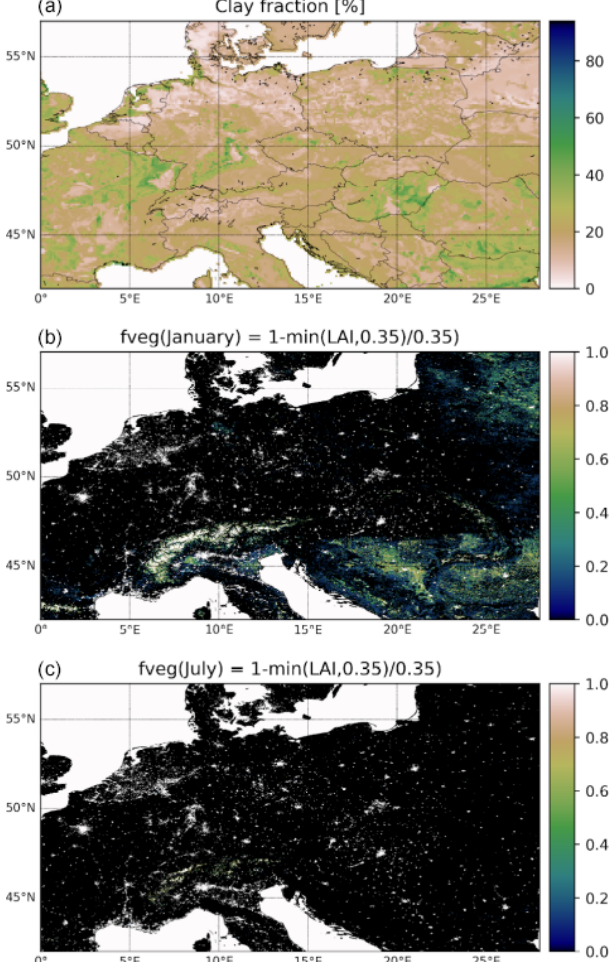
Figure 1. The input data for the clay fraction in percent (a) and the vegetation factor for January and July ( b and c , respectively) based on MODIS 2010 LAI